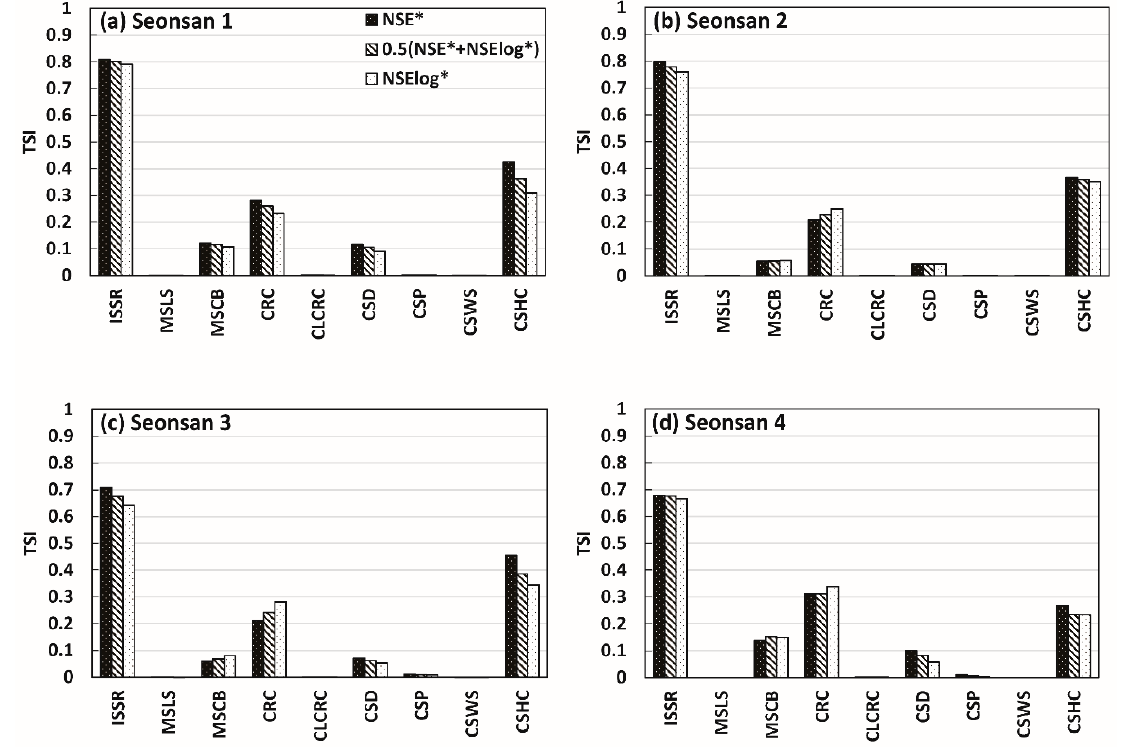
Figure 7. Parameter sensitivity of the four rainfall events in Seonsan catchment, calculated for the three objective functions: ( a ) Seonsan 1; ( b ) Seonsan 2; ( c ) Seonsan 3; ( d ) Seonsan 4.